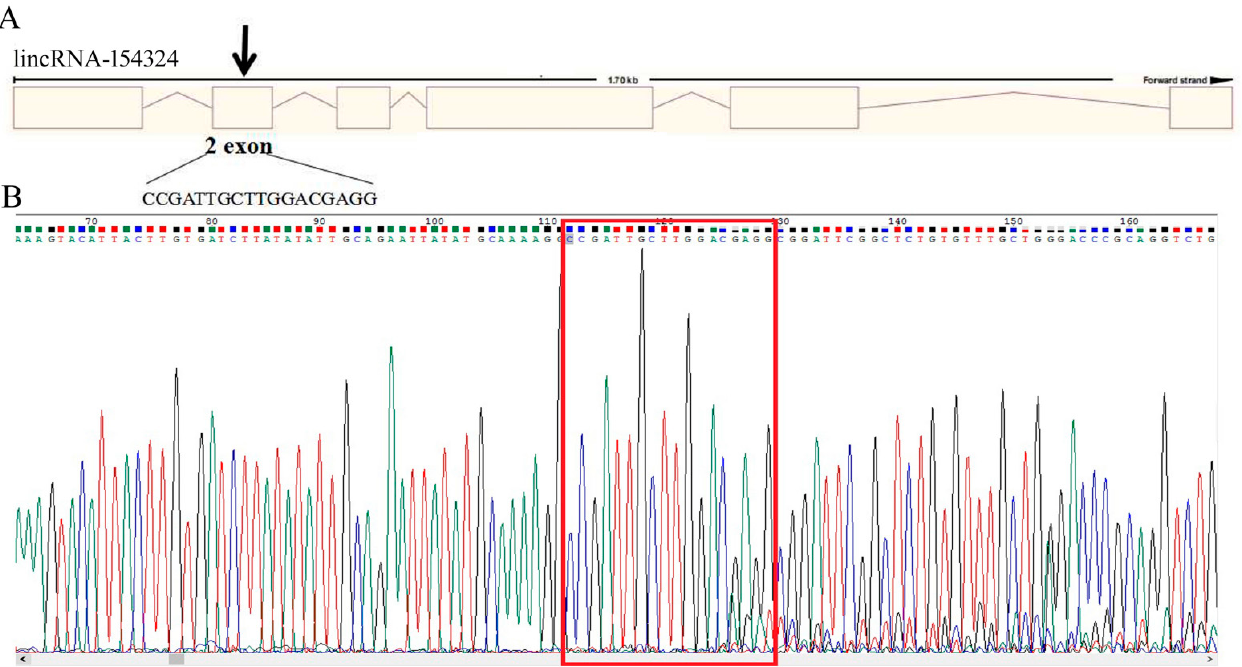
Figure 8. The sequence detection results for lincRNA-154324 knockout. ( A ) Gene architecture of lincRNA-154324 showing the target site of the SgRNA. ( B ) The sequence detection results for lincRNA-154324 knockout for embryos at 24 hpf. The red box indicates the knockout target site area.